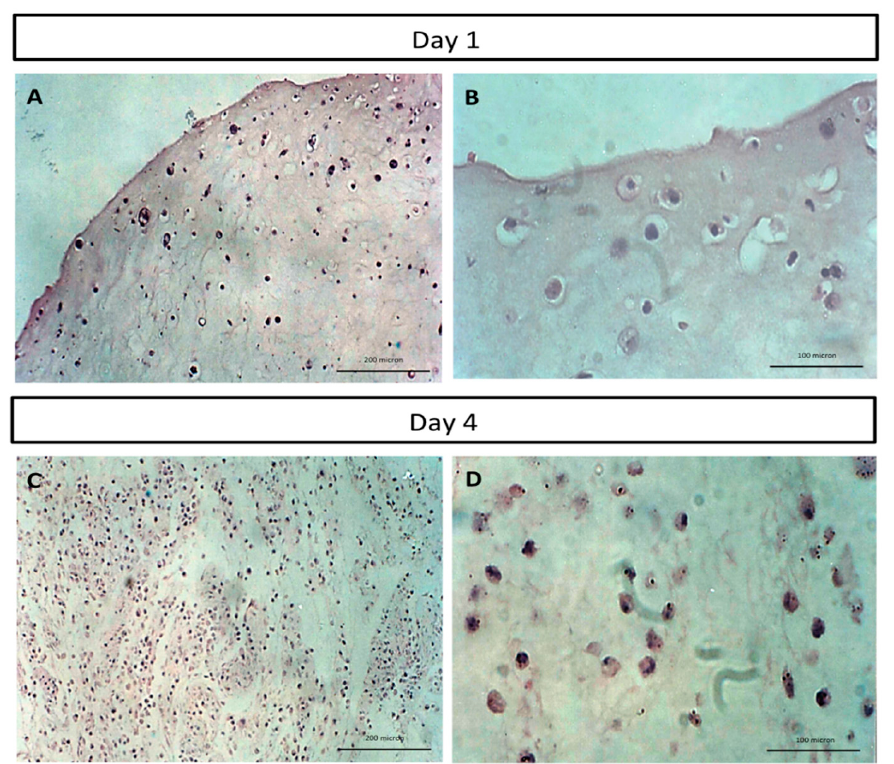
Figure 2. Cross-section view of the hematoxylin and eosin-stained human tissue respiratory epithelial construct (HTREC): ( A , B ) show a layer of the construct with respiratory epithelial cells residing within the calcium chloride polymerized-human plasma at day 1 with 100 × and 200 × magnifications, respectively. ( C , D ) show the same construct at day 4 with 100 × and 200 × magnifications, respectively. The cells were found expanding and proliferating within the HTREC. Results are from a representative of three biologically independent experiments.